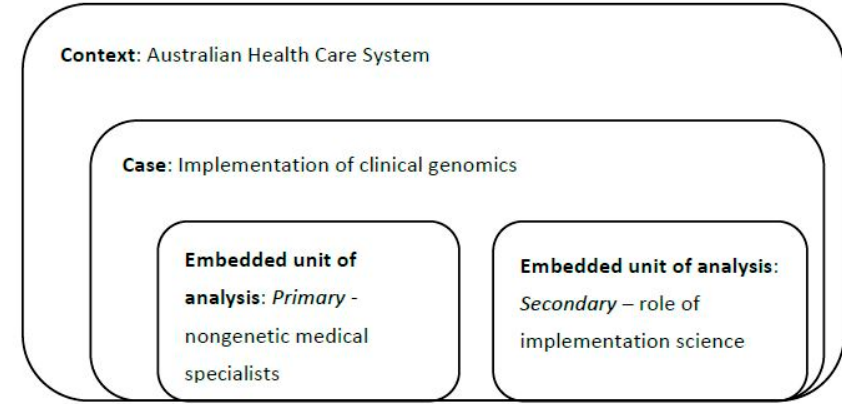
Figure 1. Single case, multiple embedded design [14] .